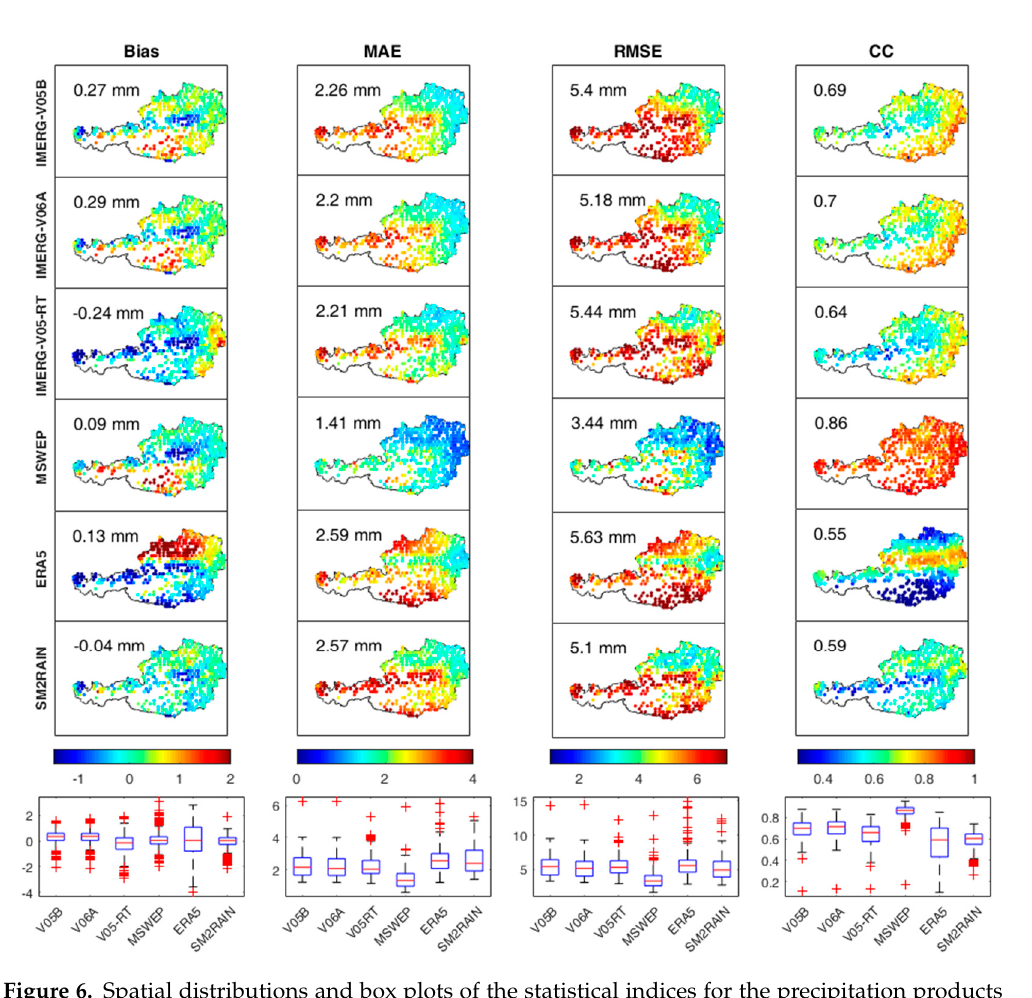
Figure 6. Spatial distributions and box plots of the statistical indices for the precipitation products and stations with the elevation equal or less than 1000 m. The center-line of each boxplot depicts the median value (50th percentile) and the box encompasses the 25th and 75th percentiles of the sample data, while the whiskers represent the extreme values, respectively.